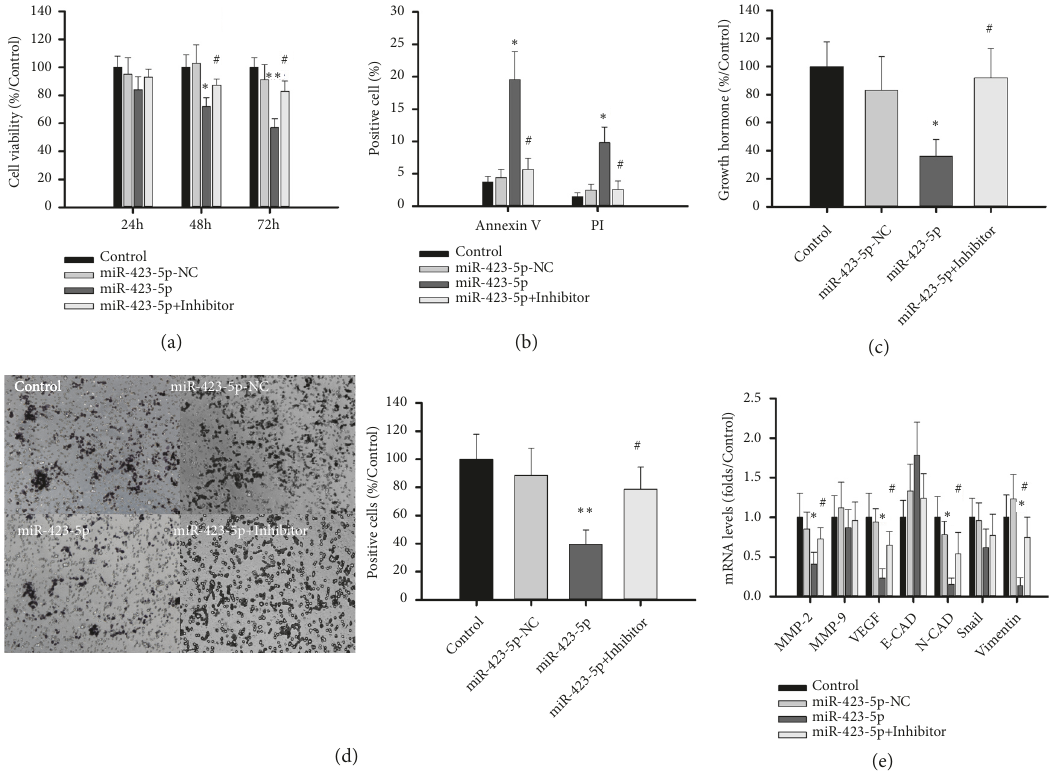
Figure 5: Effect of miR-423-5pon cell growth, apoptosis, growth hormone release, and migration of GH3 cells. (a): Viability of GH3 cells after miR-423-5ptransfection for 24h, 48h, and 72h. (b): miR-423-5p induced GH3 cell apoptosis after transfection for 24 h. (c): miR-423-5p reduced growth hormone release by GH3 cell cultures. (d): Transwell experiments showing miR-423-5p reduced transmembrane GH3 cells after transfection for 24h. (e): miR-423-5p inhibited mRNA of migration-related genes N-CAD, vimentin, VEGF, and MMP2 ∗ compared to a control group. ∗ p < 0.05, ∗∗ p < 0.01, #compared to miR-423-5p p < 0.05, n =